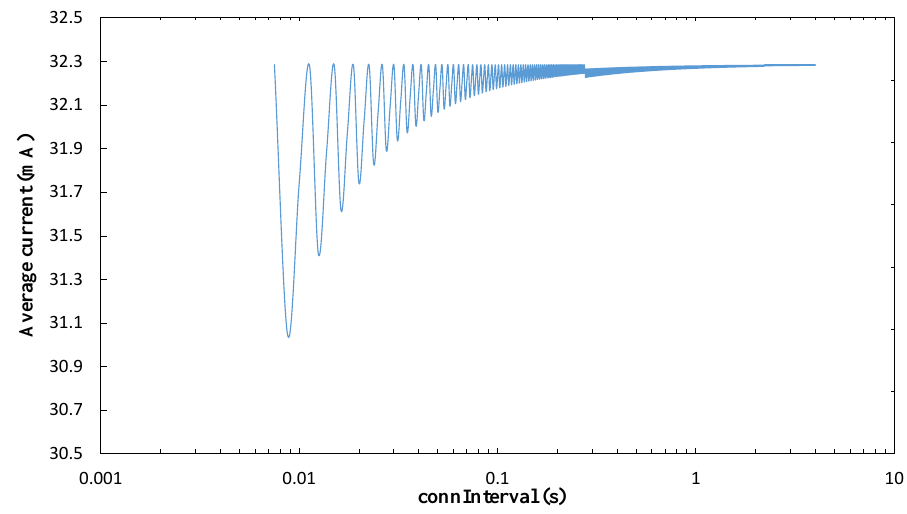
Figure 10. Average current consumption of the sensor node within connInterval ( I avg_CI ) in the connection-based approach, as a function of connInterval , and for BER = 0.